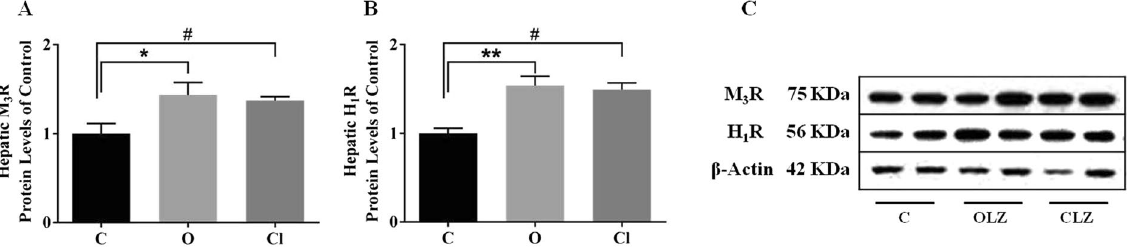
Figure 6. Response of hepatic M3-muscarinic receptors (M 3 R) and H1-histamine receptors (H 1 R) to chronic treatment with OLZ or CLZ. Western blot analysis of the protein expression of M 3 R ( A ) and H 1 R ( B ) (n = 6 per group) in liver tissue lysate. Representative blots are shown ( C ). All data are presented as mean ± SEM. * p < 0.05 and ** p < 0.01: OLZ treatment vs. control, # p < 0.05: CLZ treatment vs . control. C: control; OLZ: olanzapine; CLZ: